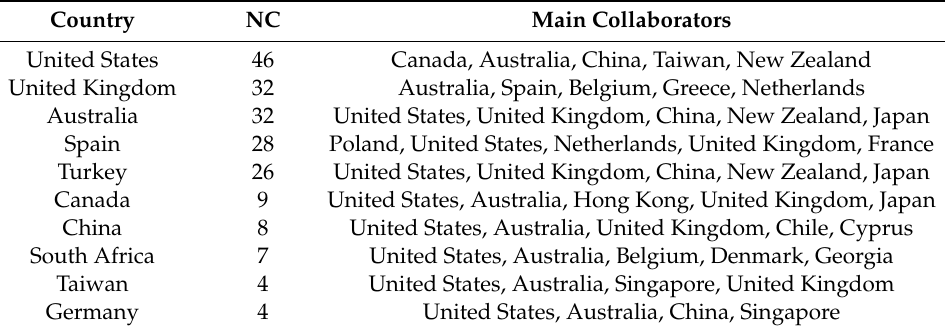
Table 8. Most productive countries and international collaboration (2004–2018). Country NC Main Collaborators United States 46